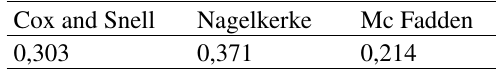
Tabel 6. Nilai pseudo R-square